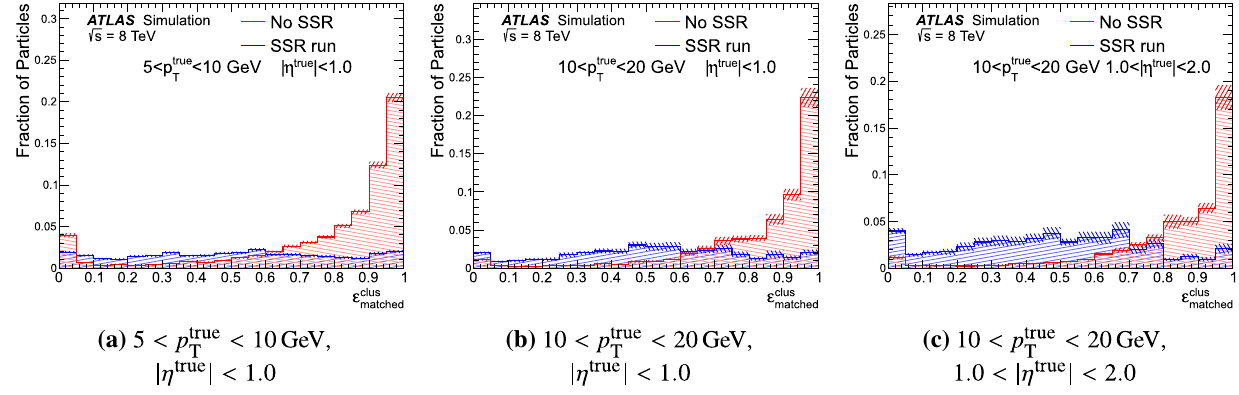
Fig. 18 The fraction of the true energy of a given particle contained within the initially matched topo-cluster for particles where the split shower recovery procedure is run (SSR run) and where it is not (No SSR). For cases where most of the energy is contained in the initially